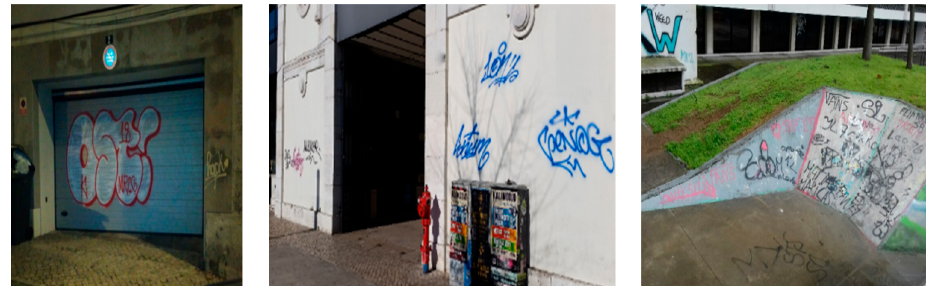
Figure 1. Examples of images with illegal graffiti.